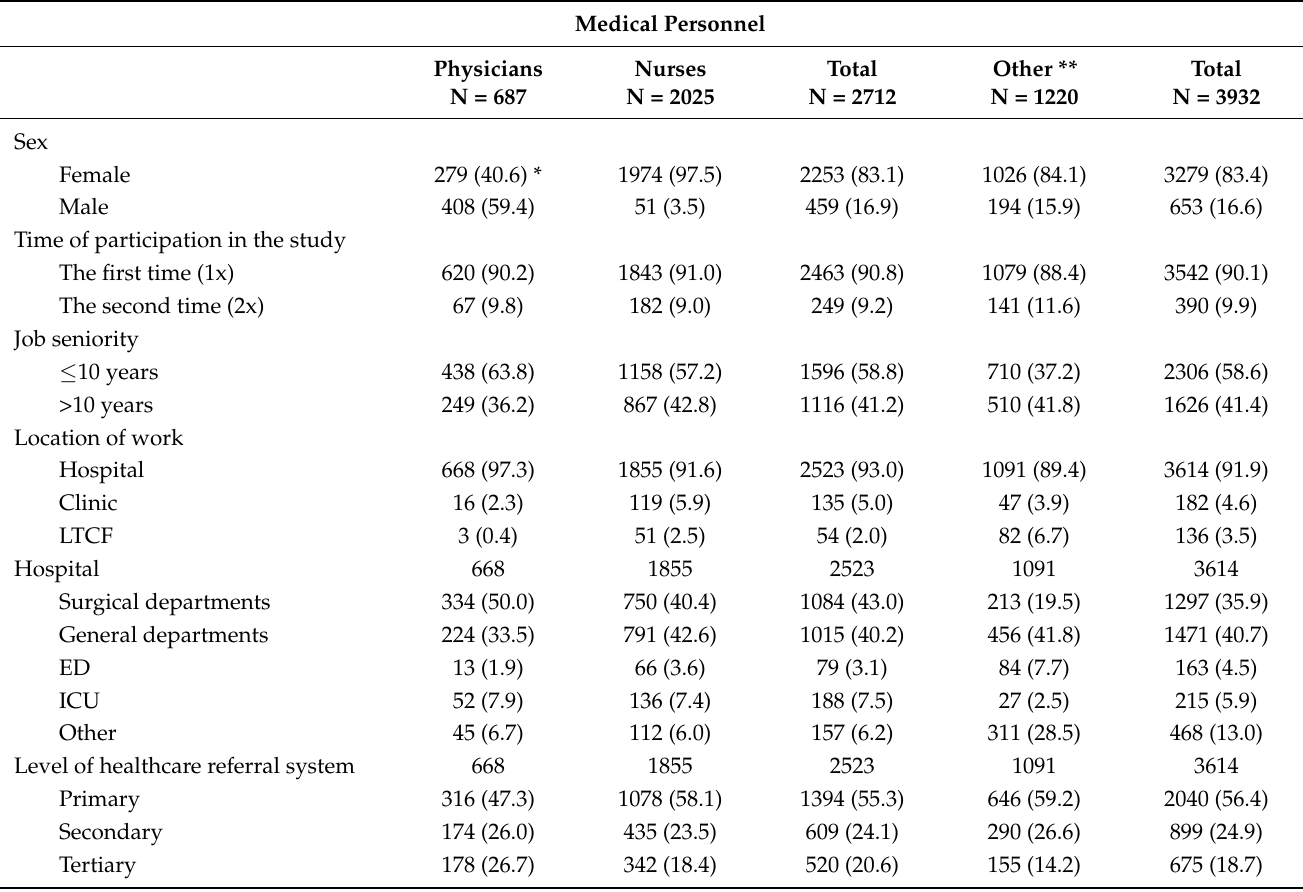
Table 3. Characteristics of personnel who adhere to the BBE concept (BBE